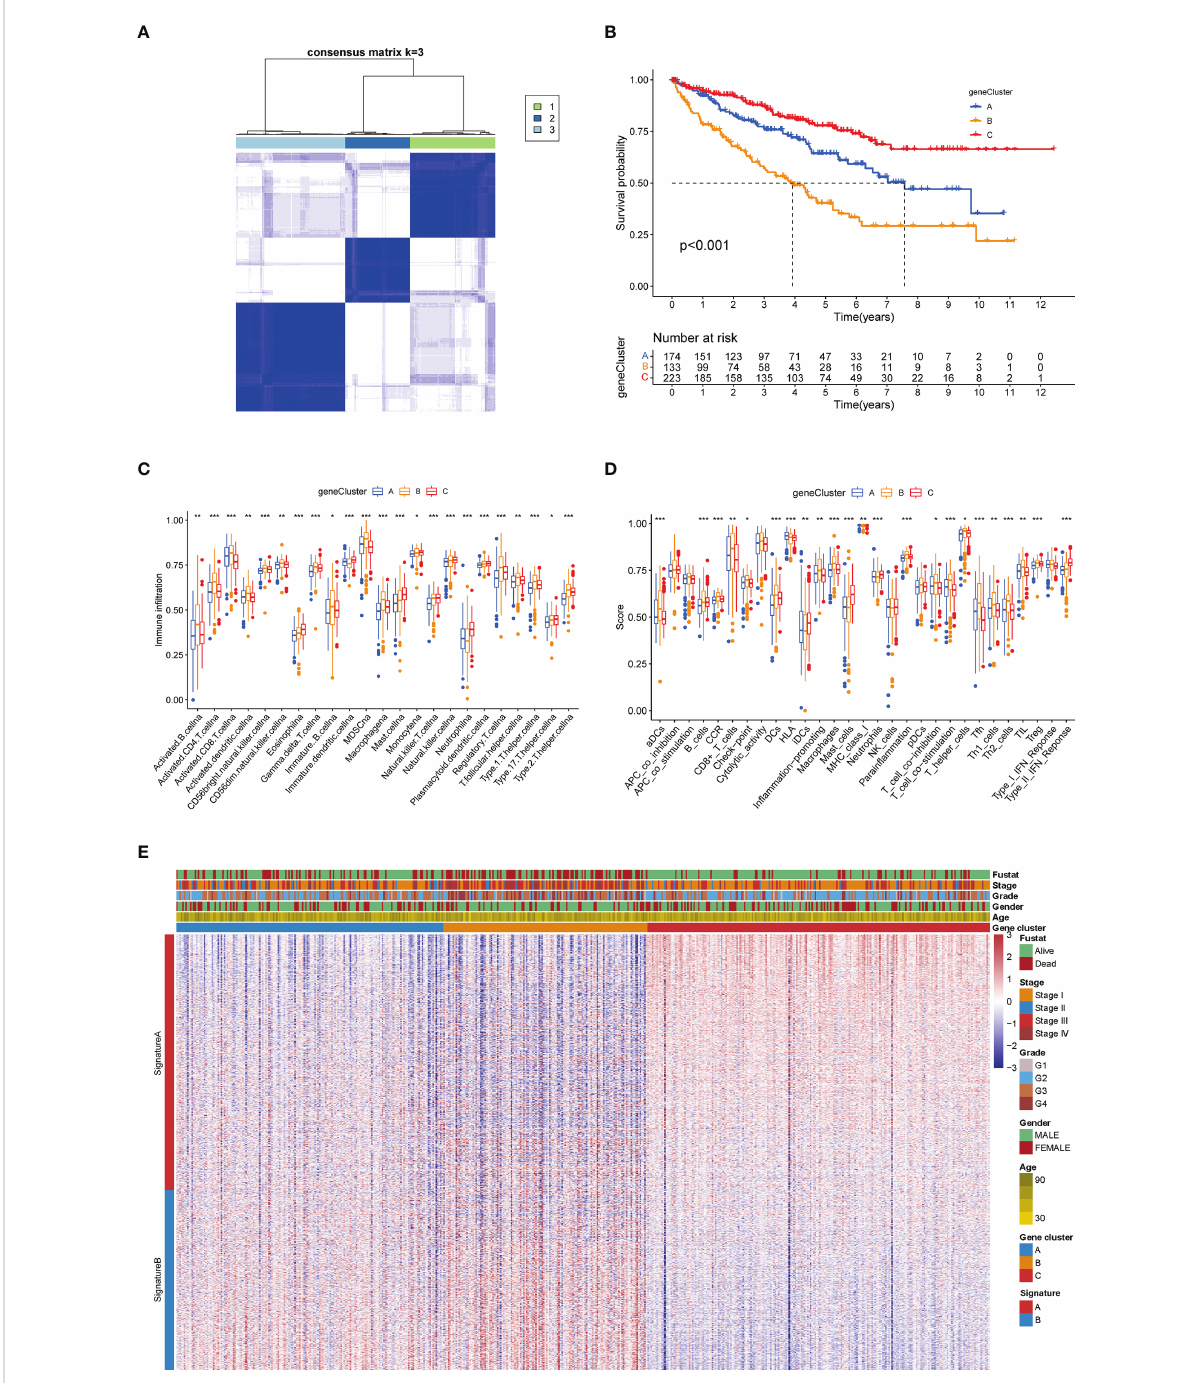
FIGURE 6 Gene clustering-based grouping of patients with distinct clinical and immune features. (A) Heatmap of the consensus matrix depicting the proper clusters (k = 3) and correlation area. (B) Kaplan – Meier survival curves of three subgroups. Analysis of immune cell in fi ltration level (C) and immune-related function (D) between three subgroups. (E) Heatmap of different clinicopathological features in three subgroups (* p < 0.05; ** p < 0.01; *** p <